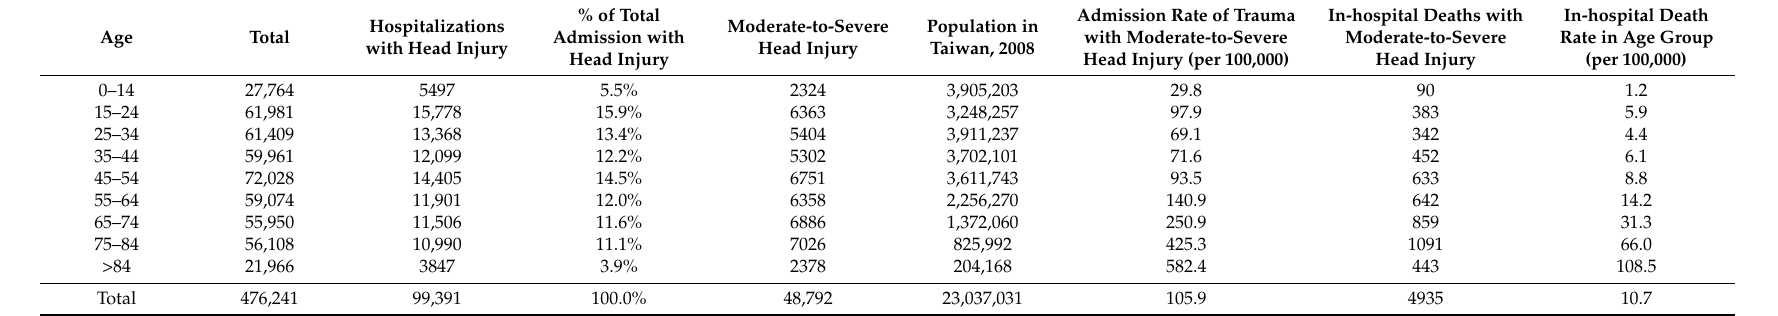
Table 3. Age distribution of trauma hospitalizations with head injury in Taiwan in